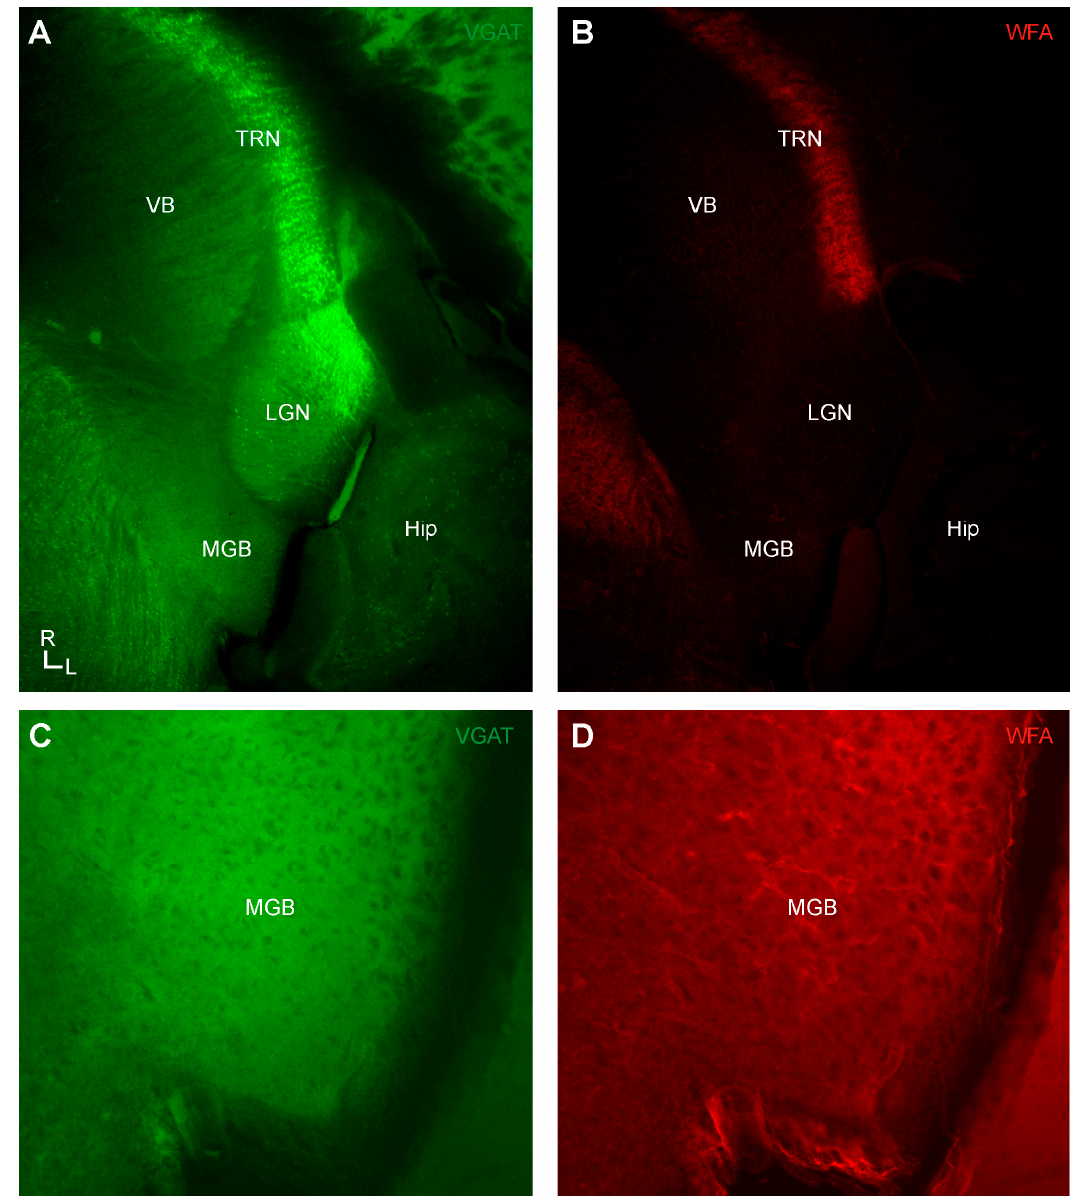
Figure 3. In the vesicular gamma-amino butyric acid transporter (VGAT)-Venus C57BL/6 mouse strain, wisteria floribunda agglutinin (WFA)-labeled perineuronal nets (PNNs) are absent in the medial geniculate body (MGB), ventrobasal complex (VB), and lateral geniculate nucleus (LGN), although abundant in the thalamic reticular nucleus (TRN): ( A ) epifluorescent image of VGAT-positive neurons (green) in each of the main sensory thalamic nuclei (MGB, VB, LGN) and the TRN; ( B ) epifluorescent image of WFA-labeled PNNs (red) in the sensory thalamic nuclei (MGB, VB, LGN) and the TRN; and ( C – D ) higher-magnification image of the MGB from A–B.